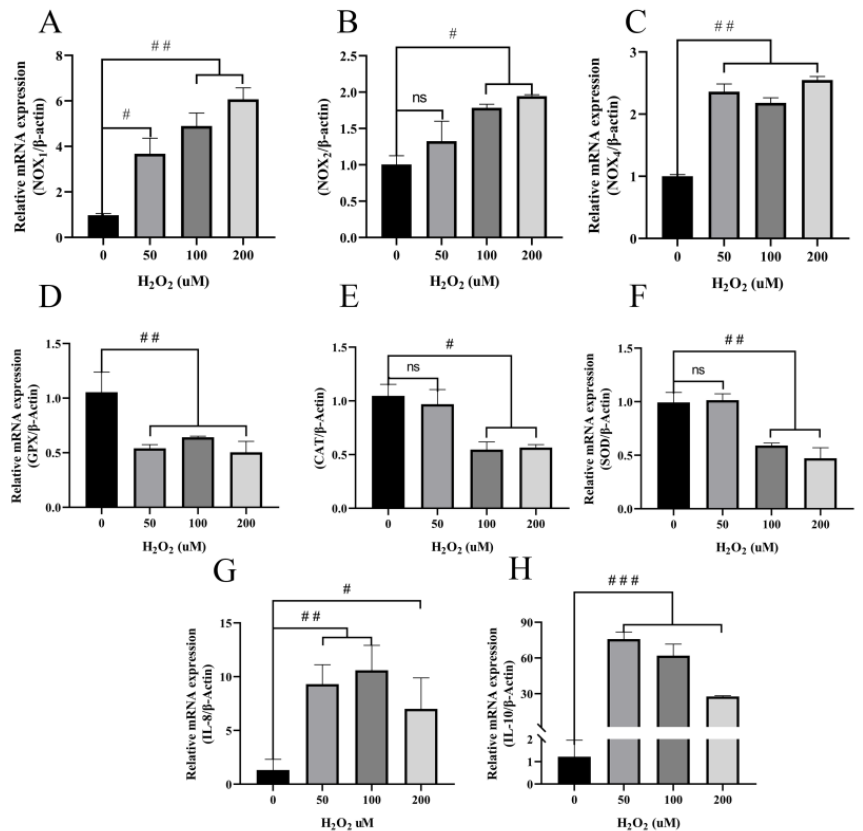
Figure 3. Oxidative stress-related factors and inflammatory cytokines in BEECs treated with different concentrations of H 2 O 2 for five hours were detected. ( A – C ) Expression of ROS-generating oxidases NOX1, NOX2, and NOX4, respectively. ( D – F ) Expression of antioxidant stress-related factors GPx, CAT, and SOD, respectively. ( G , H ) Expression of inflammatory cytokines IL-8 and IL-10, respectively. The experiment was repeated at least three times. All data are means ± S.E. One-way ANOVA analysis was used to compare to the control group. # p < 0.05, ## p < 0.01, ### p < 0.001, ns no significance.